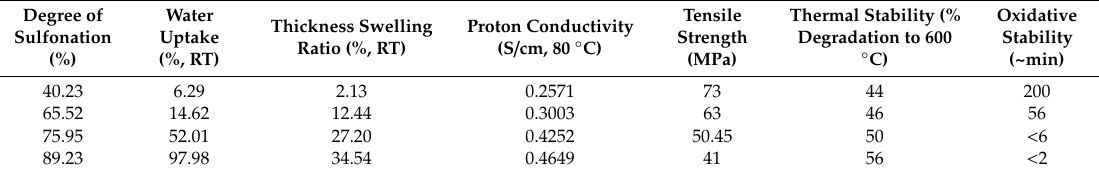
Table 2. Property changes in the sulfonated poly(ether ether ketone) (SPEEK) membrane with varying degrees of sulfonation